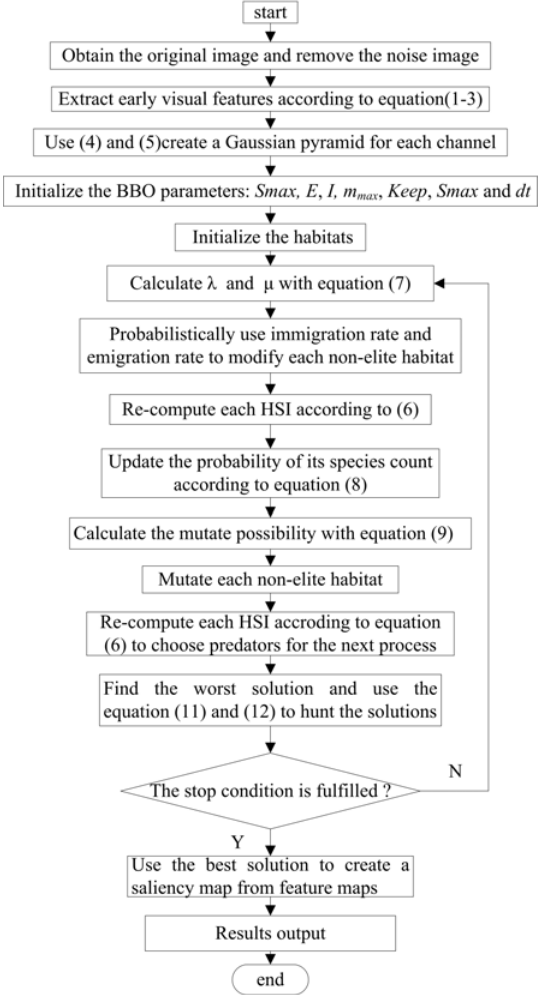
Fig.3. Flowchart of PPBBO for visual